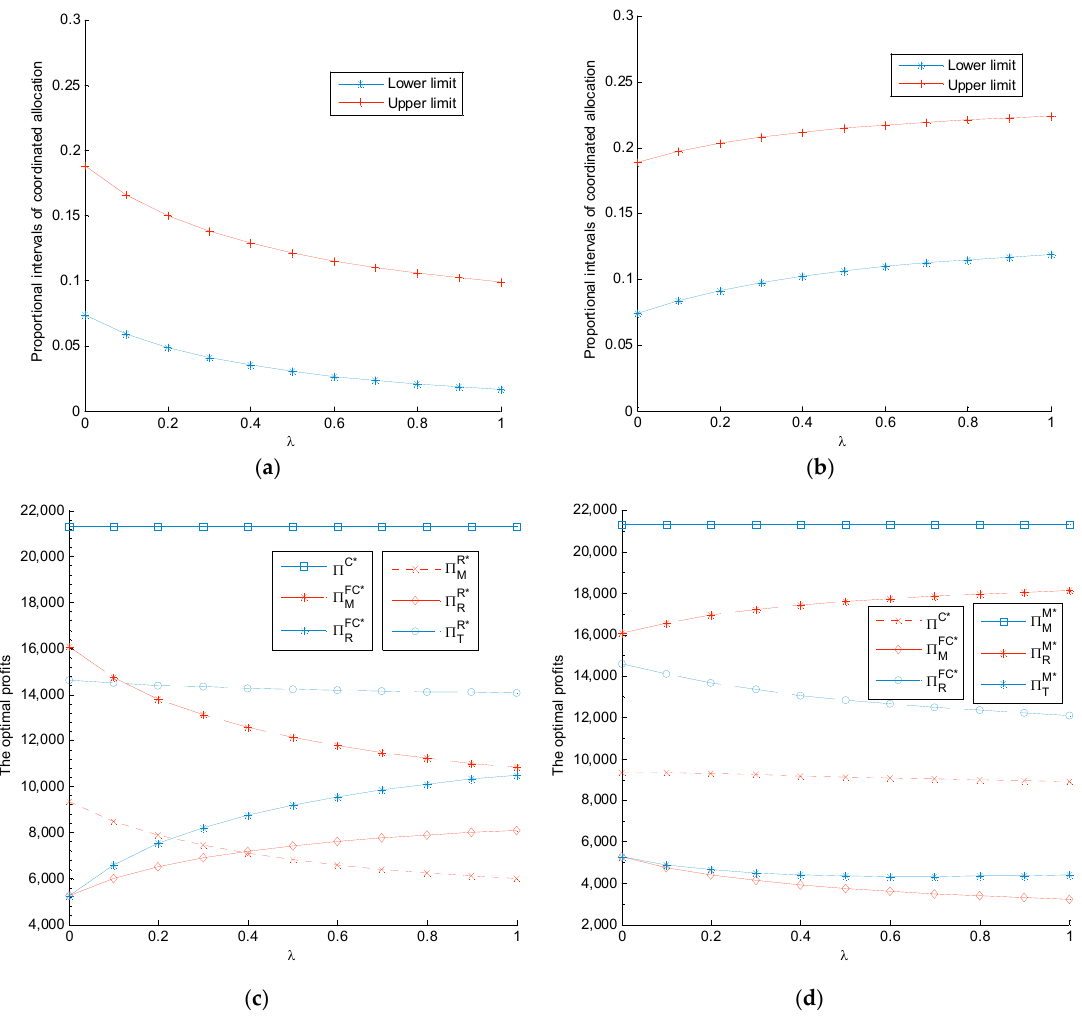
Figure 4. The impact, λ , on the assignment proportion range and the supply chain members’ profits under the revenue ‐ sharing contract: ( a ) coordination assignment range of Model R ; ( b ) coordination assignment range of Model M ; ( c ) supply chain members’ profits under the revenue ‐ sharing contract of Model R ; and ( d ) supply chain members’ profits under the revenue ‐ sharing contract of Model M .